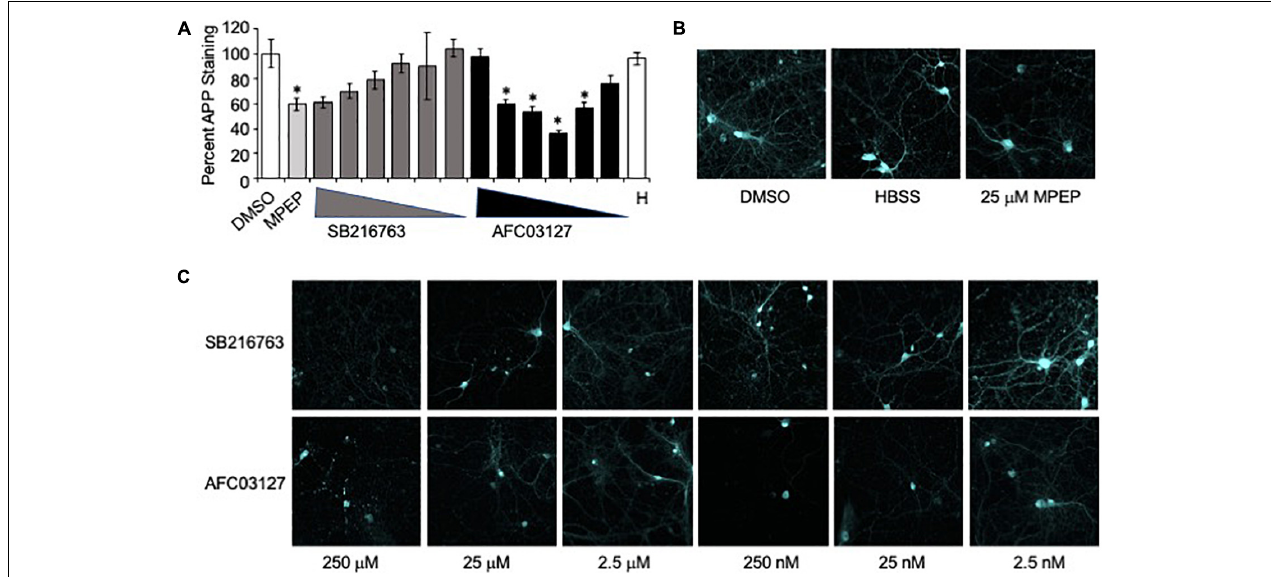
FIGURE 3 | GSK3 inhibitors reduce neuronal APP expression in Fmr1 KO mice. (A) Primary cultured Fmr1 KO neurons were treated with MPEP (25 µ M) versus SB216763 and AFC03127 over a concentration range of 2.5 nM–250 µ M, stained with anti-APP antibody conjugated to Alexa Fluor R (cid:13) 647 and images acquired with a 60x objective. Average APP staining intensities of 3–5 dendrites per cell for 9–18 cells (3–6 cells per slide, 3 slides per treatment) were plotted against drug treatment. Statistical significance was determined by ANOVA ( p < 0.0001, F = 4.533, and dF = 14) with Dunnett’s post hoc multiple comparison test ( Supplementary Table 1 ). Error bars represent SEM. Asterisks denote statistically significant differences in APP staining compared to vehicle-treated ( p < 0.05). (B) Representative images are shown for vehicle, HBSS (H) and MPEP controls. (C) Representative images are shown of neurons treated with SB216763 and